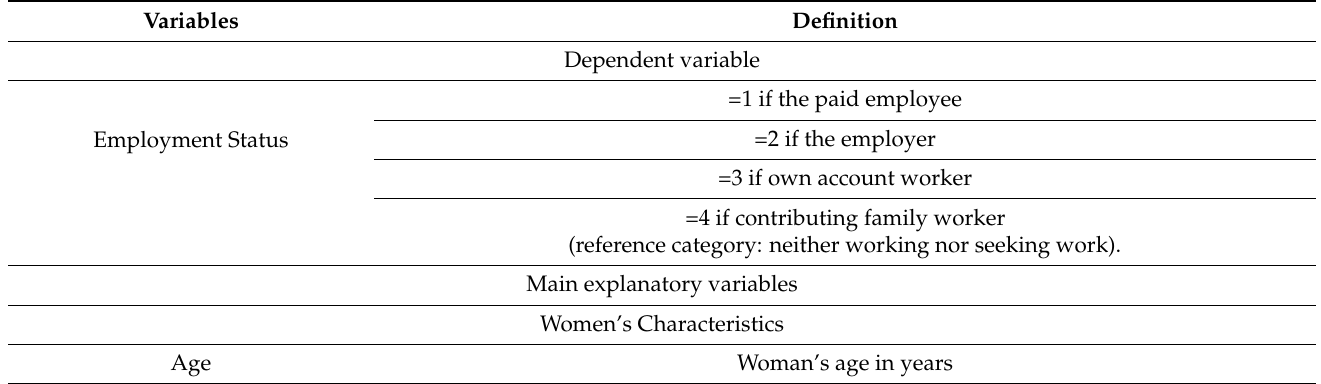
Table 1. Definitions of